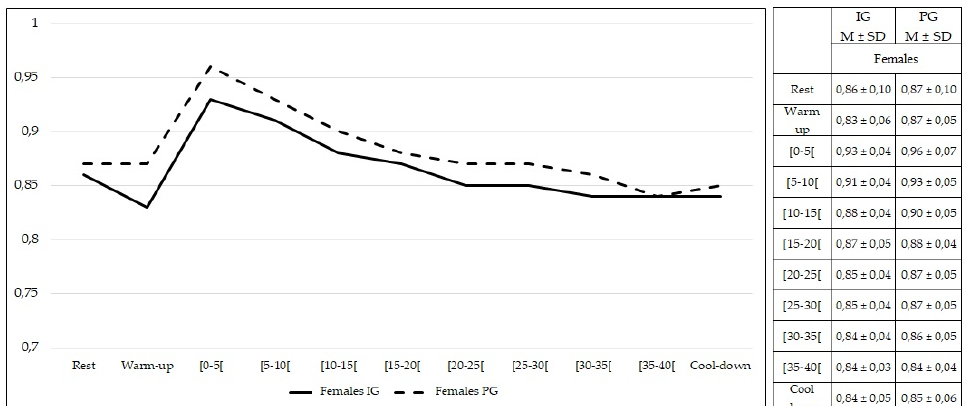
Figure 10. Respiratory exchange ratio values during rest, exercise, and cool-down in intervention group and placebo group. Data are expressed as mean ± standard deviation. IG: intervention group; PG: placebo group.